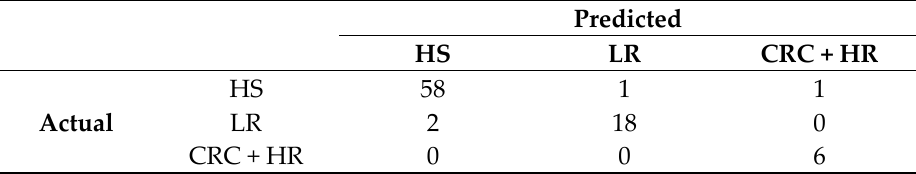
Table 1. Results obtained by analyzing a part of the responses of the samples measured within the Protocol that compares FOBT with SCENT A1 test and colonoscopy results. This data have been extrapolated by PCA treatment and